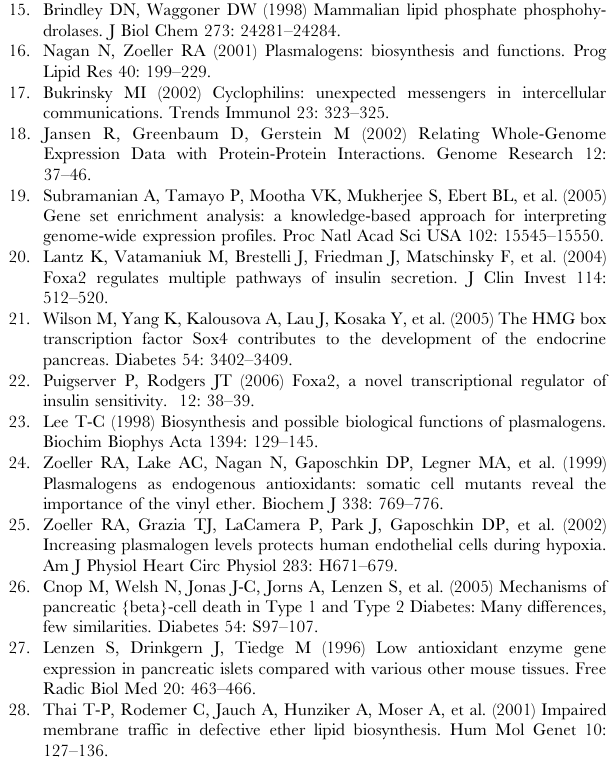
Figure S2 Upregulated paths in BDC2.5/NOD vs. NOD comparison. The nodes are colored using the same color code as in Figure 2. Edge annotations related to the source database: K, KEGG; M, MINT. Figure S3 Downregulated paths in BDC2.5/NOD vs. NOD comparison. The nodes are colored using the same color code as in Figure 2. Edge annotations related to the source database: K, KEGG; M, MINT. Figure S4 Upregulated paths in BDC2.5/NOD.scid vs. NOD.s- cid comparison. The nodes are colored using the same color code as in Figure 2. Edge annotations related to the source database: K, KEGG; M, MINT. Figure S5 Downregulated paths in BDC2.5/NOD.scid vs. NOD.scid comparison. The nodes are colored using the same color code as in Figure 2. Edge annotations related to the source database: K, KEGG; M, MINT. Figure S6 Meta-analysis for upregulated genes in BDC2.5/ NOD vs. NOD comparison. Genes are presented as rows and study group comparisons as columns.